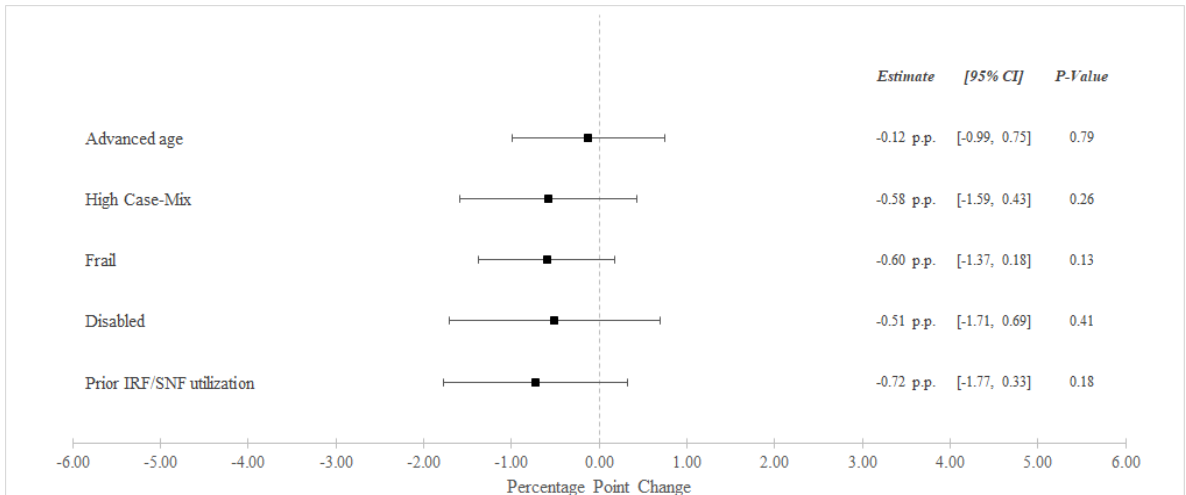
Figure 2. Adjusted Changes in 90-Day Unplanned Readmission Rate ‡ for Medical Condition Epi- sodes Among High-Risk Patients (2011–2016). Abbreviations: IRF = Inpatient Rehabilitation Facility; SNF = Skilled Nursing Facility. ‡ At least one acute care readmission during the 90-day episode. Advanced age = Age > 85 years old. High Case-Mix = Top 20% of Elixhauser score. Prior IRF/SNF Utilization = Utilization within the preceding 12 months.